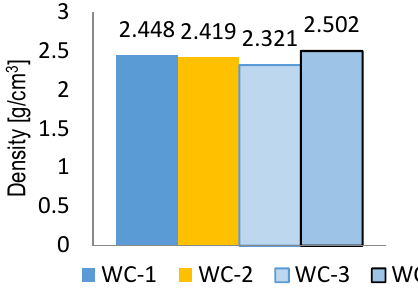
Figure 3. Density of mineral-asphalt mixtures.